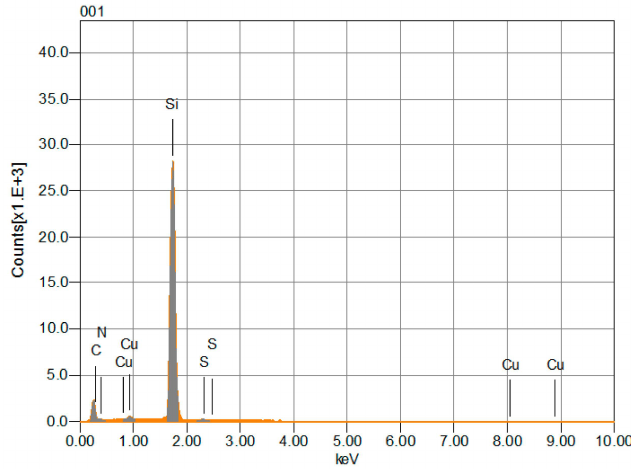
Figure 3. EDS spectra for the TTF deriv -CuPc thin film deposited on a silicon wafer.